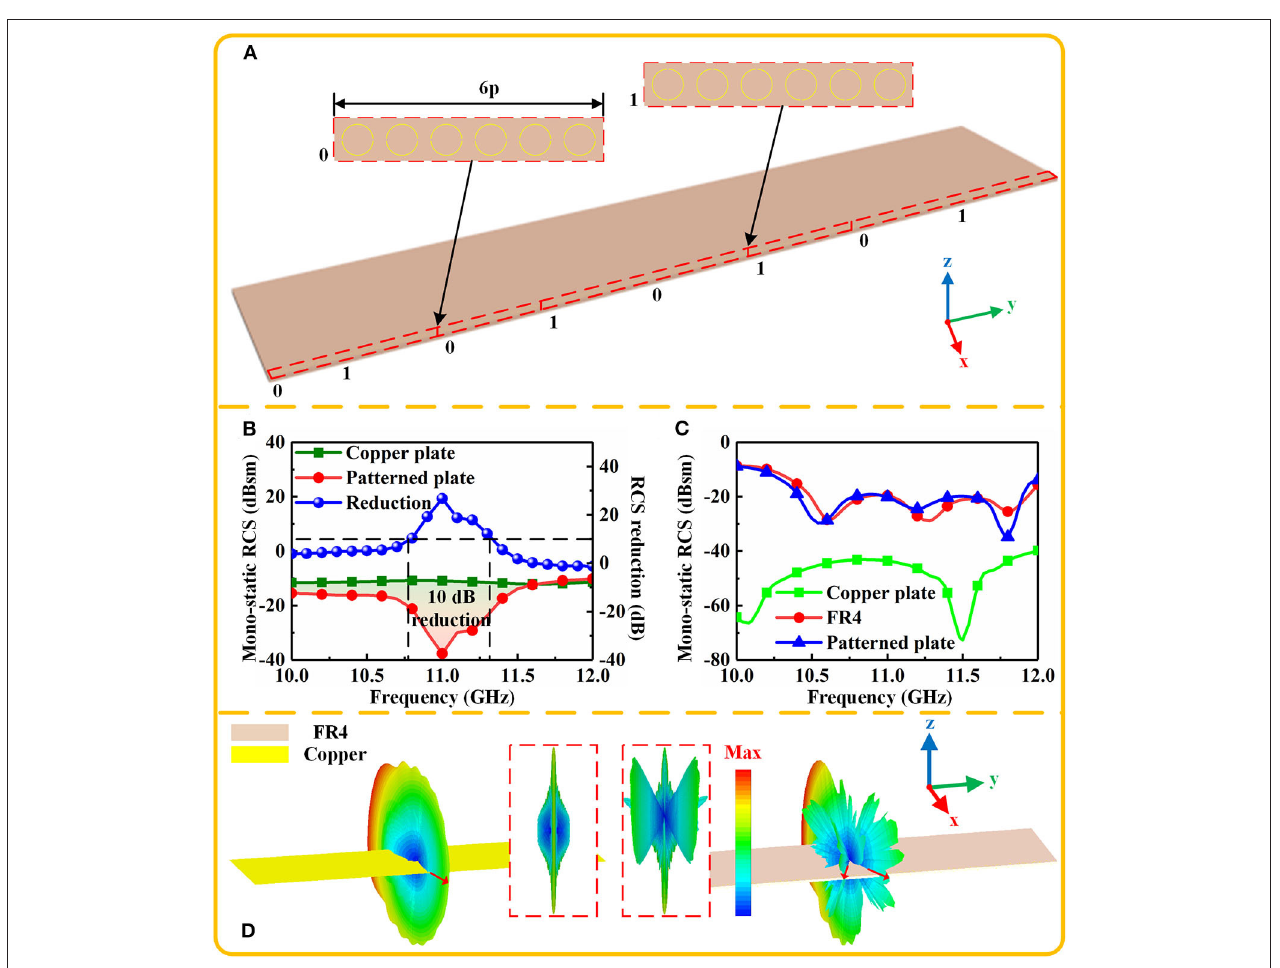
FIGURE 5 | (A) The configuration of patterned plate with coding metasurface purfle constituted by anti-phase coding elements. (B) The mono-static RCS of copper plate and patterned plate under horizontal polarization. (C) The mono-static RCS of copper plate, FR4 substrate with copper ground plane and patterned plate under vertical polarization. (D) The RCS plane of copper plate and patterned plate under horizontal polarization at 11 GHz.